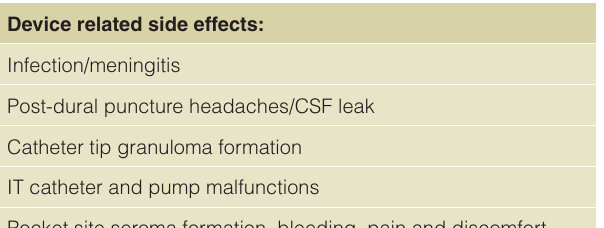
Table 6. Device related side effects 2 . Device related side